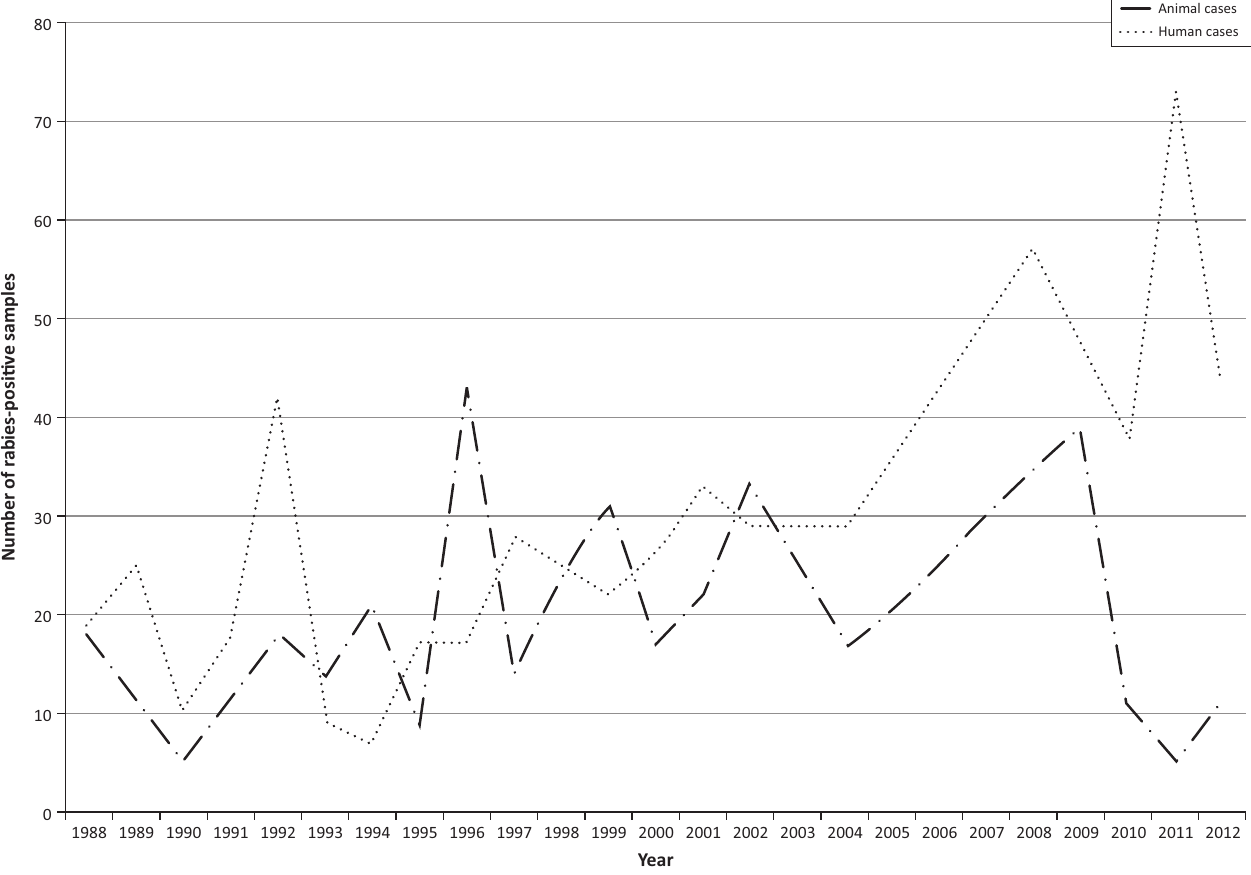
FIGURE 1: The number of animal and human samples diagnosed as rabies-positive at the Central Veterinary Laboratory in Maputo, Mozambique, over the last 25 years